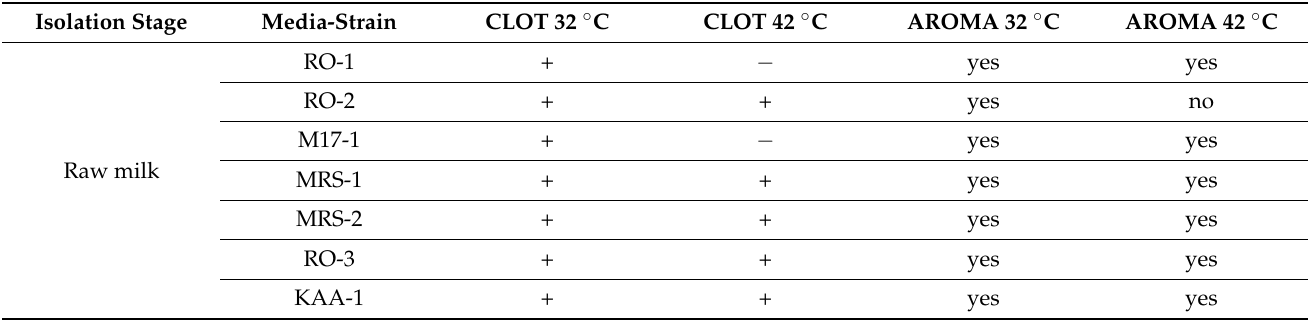
Table 1. Technological properties of LAB